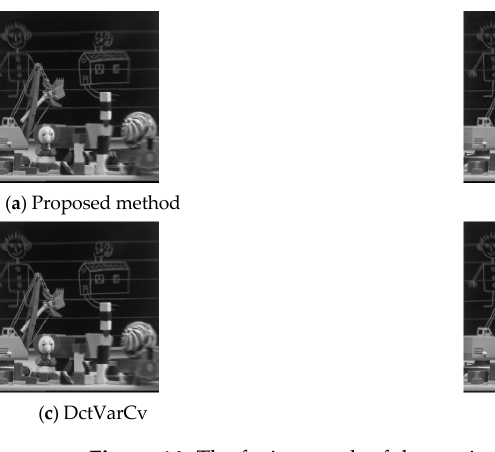
Figure 14. The fusion result of the toy image. Table 1. List of aircraft fusion results and fusion quality indicators.